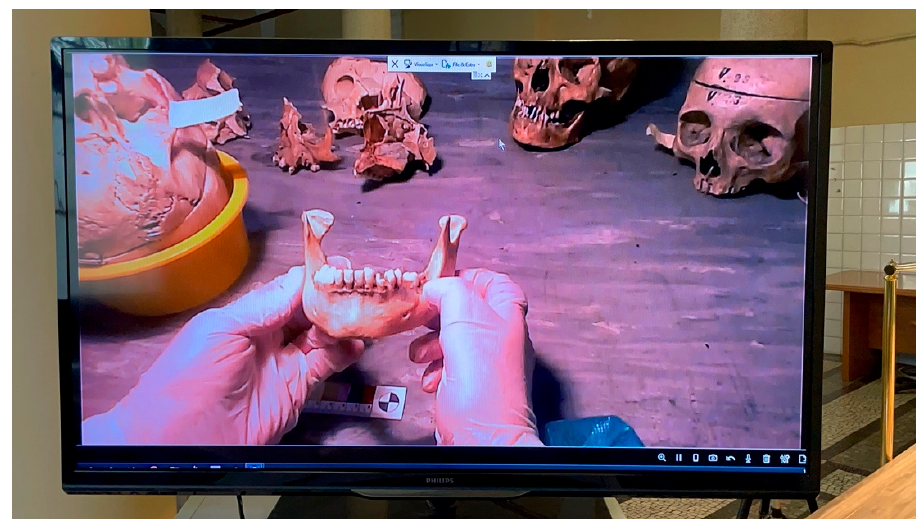
Figure 4. Live streaming images observed remotely from a forensic odontologist.